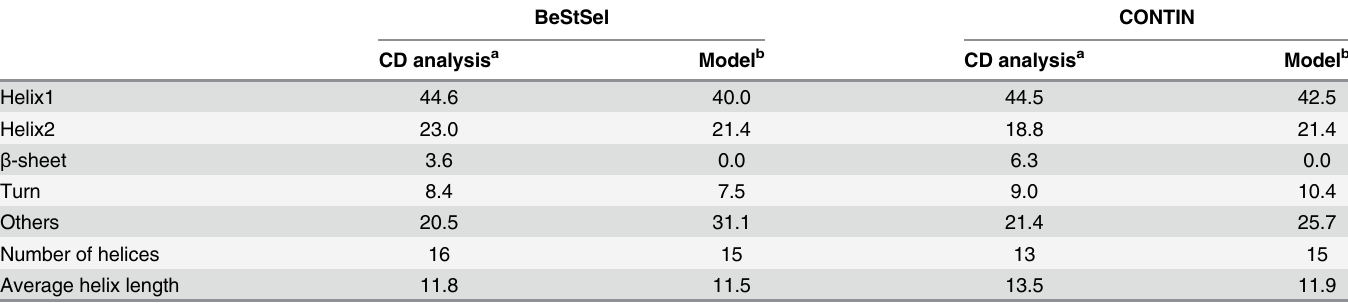
Table 1. Secondary structure estimation from the synchrotron radiation CD spectrum of Stl and comparison to the homology